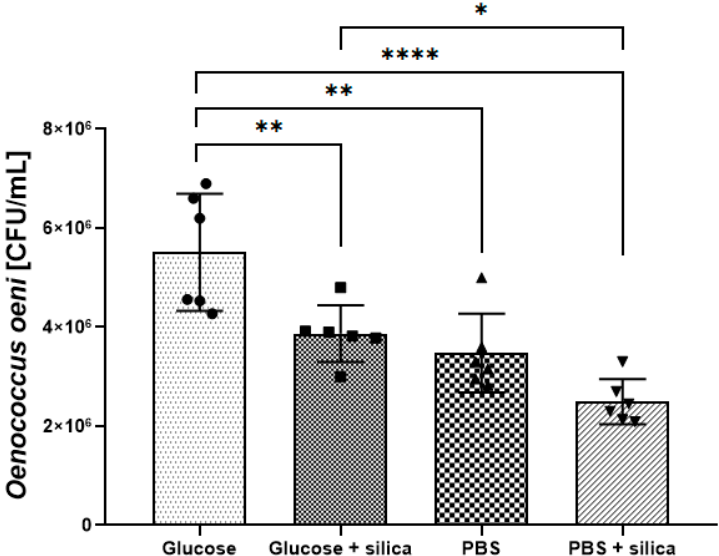
Figure 3. Diagram of silica nanospheres’ cytotoxicity effect on Oenococcus oeni (DSM7008) cells in PBS and glucose solutions. Data are expressed as mean ± SD. Asterisks within a bar graph indicate significant di ff erences between the means; * p < 0.05, ** p ≤ 0.01, **** p < 0.001, one-way ANOVA followed by the Tukey’s multiple-comparison test.